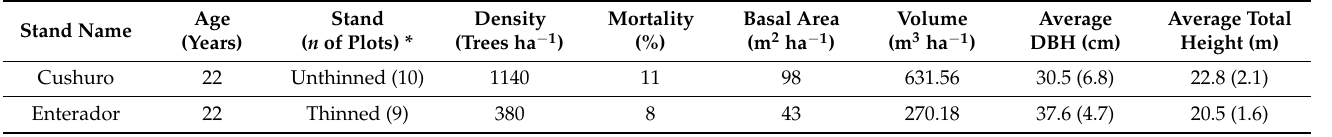
Table 1. Characteristics of the sampled stands. Growth data based on measurements taken outside of the bark. Standard deviations are provided in brackets.